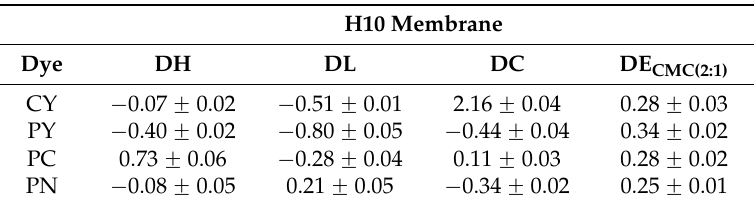
Table 4. Colour differences values for the H10 membrane.